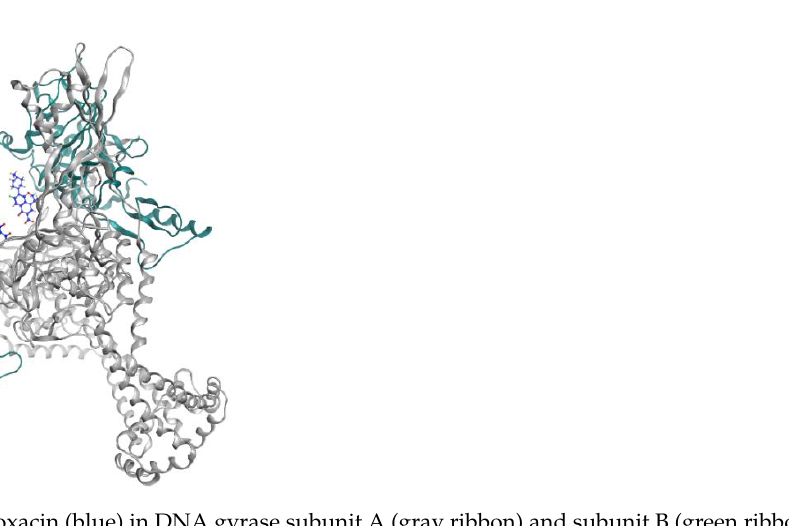
Figure 1. Structure of ( A ) moxifloxacin, ( B ) gatifloxacin, and ( C ) levofloxacin.